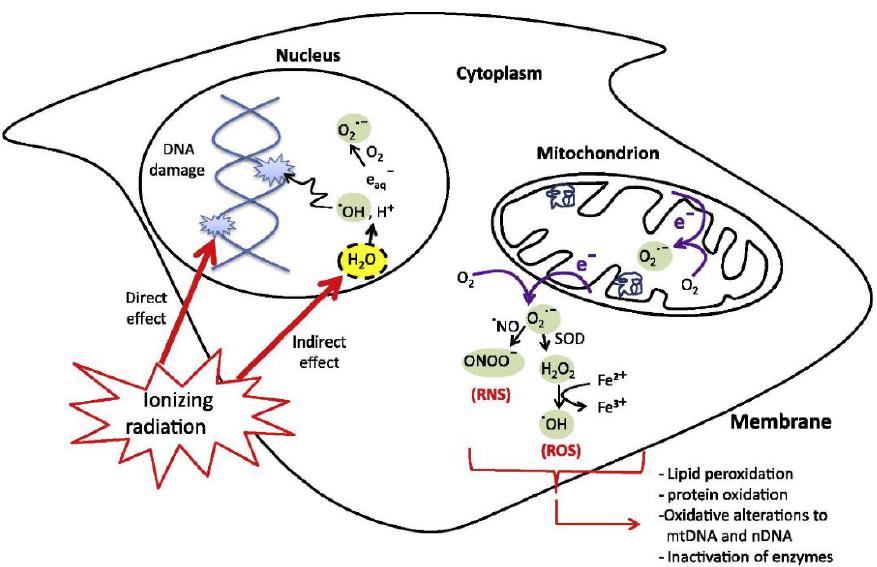
Figure 2. Direct and indirect cellular effects of IR. Reprinted with permission from Ref. [75]. Copyright 2022, American Chemical Society.